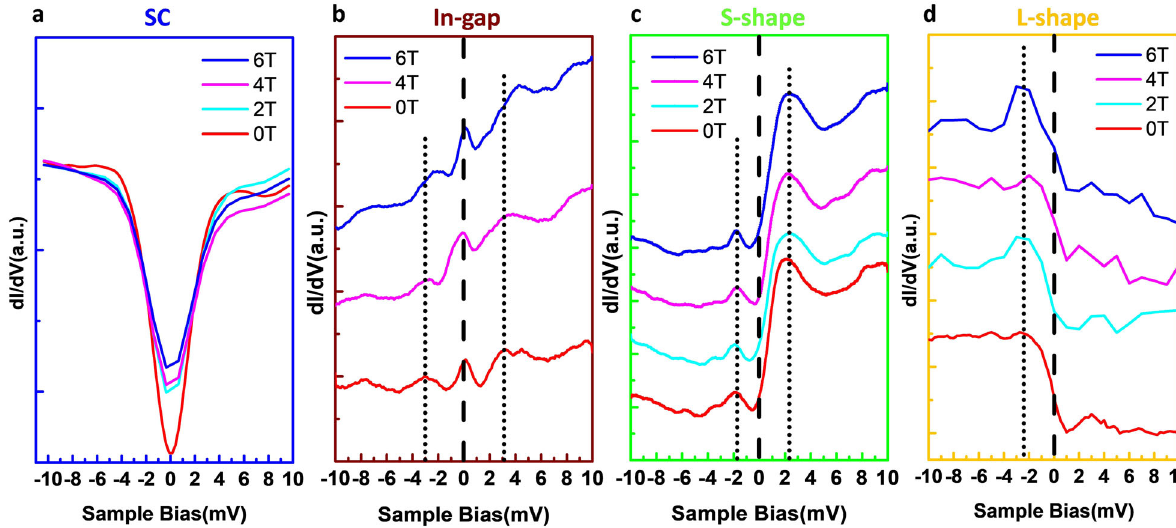
Fig. 5 Magnetic fi eld dependence of the spectra of Co-122. a – d SC, in-gap, S-shape, and L-shape spectra measured in a magnetic fi eld of 0 – 6 T at 2.0 K. The dashed lines are guides for the eye. Each set of fi eld-dependent spectra is collected at the same atomic locations; the curves in ( b – d ) are offset vertically for